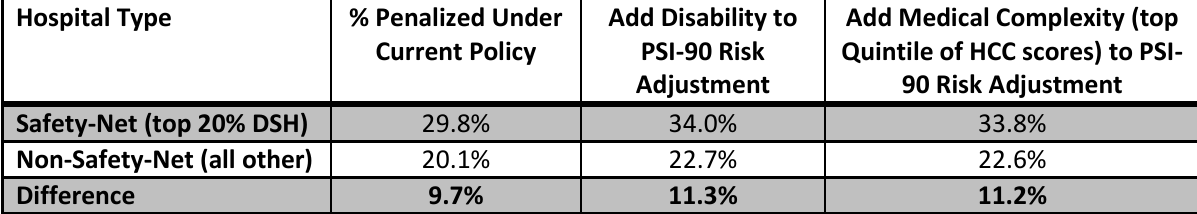
Table 6.15: Percent Penalized After Adjusting PSI-90 for Disability or Medical